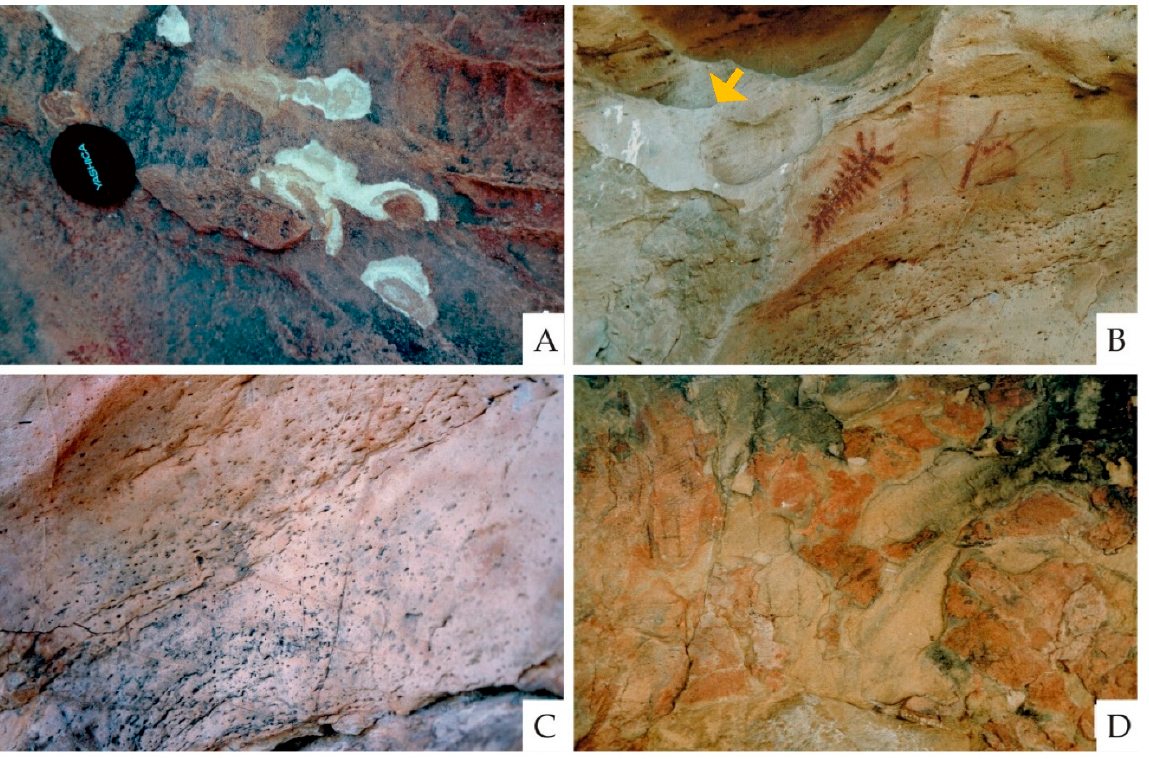
Figure 6. Weathering products. ( A ) Flaking processes and bleaching; Cueva del Arco. ( B ) Incipient alveolar weathering affecting schematic Palaeolithic rock paintings; on top left, bird droppings (arrows); Shelter 13. ( C ) Detail of alveolar weathering; Shelter 13. ( D ) Flaking; Shelter 17.